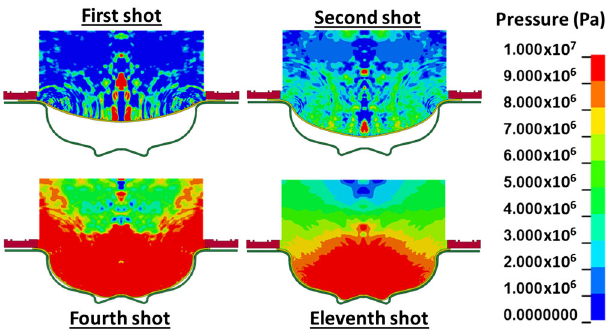
FIG. 6. Pressure evolution inside the water tank for different shots during forming of